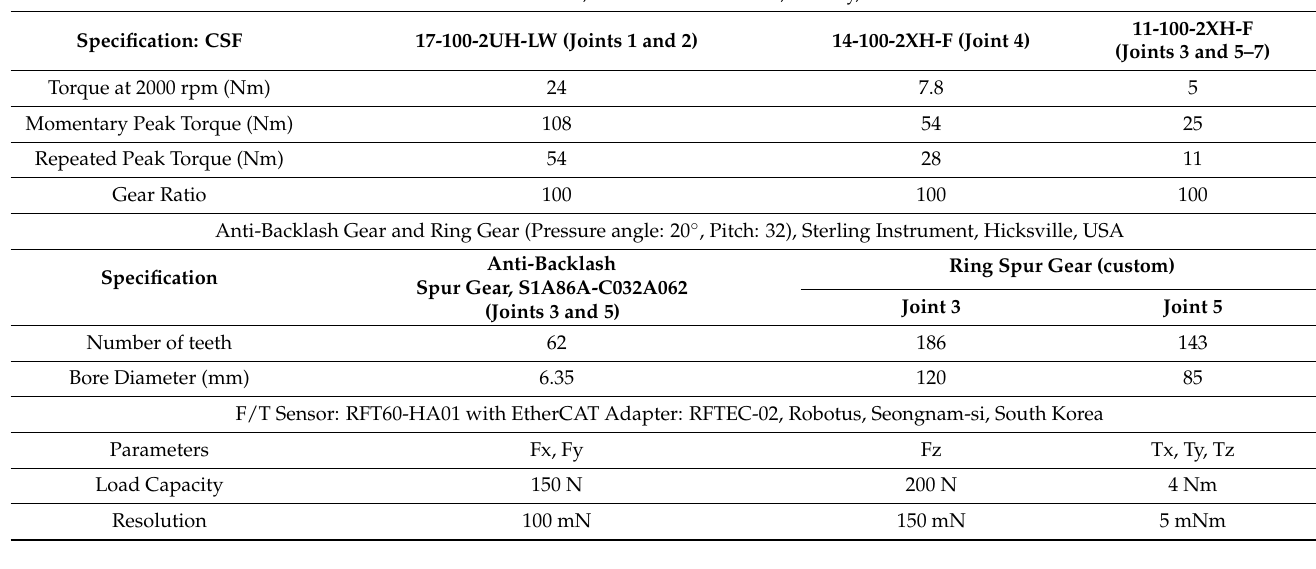
Table 2. Mass and inertia properties of the SREx